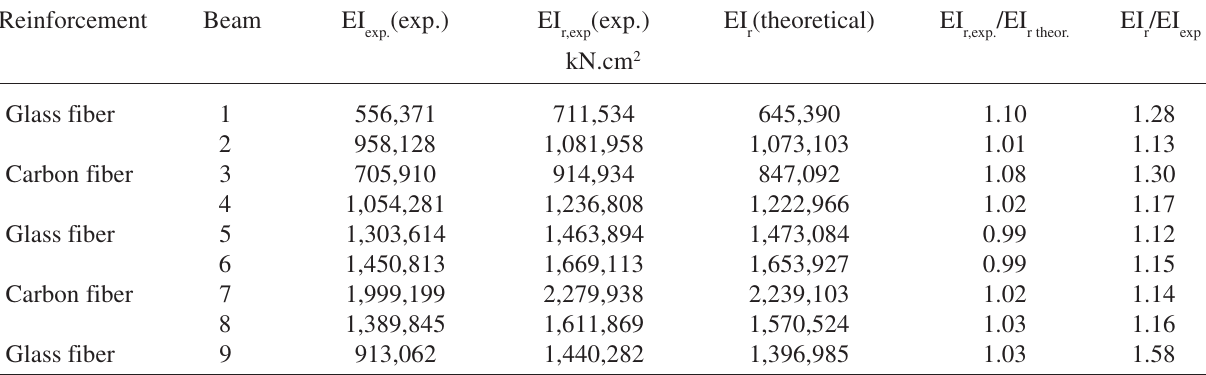
Table 6. Experimental and theoretical moment of failure. Rein- Beam Experimental Theoretical Relation